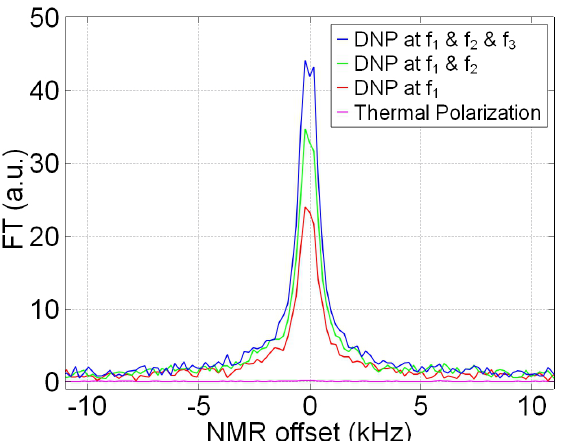
Figure 5. Comparison between thermally polarized 13 C at 6 T and hyperpolarized 13 C nuclei obtained by the optical DNP at 17.6 mT. All the measurements are performed on the same diamond at room temperature. The pink line represents FT signal obtained from thermally polarized 13 C nuclei with 400 averages. The red, green and blue lines represent the FT signals obtained with MW excitations at single ( f 1 ), double (f 1 , f 2 ) and triple (f 1 , f 2 , f 3 ) frequencies, respectively. The spectral positions of f 1 , f 2 and f 3 are indicated in Figure 2a. The 13 C polarization increases from 0.068%, through 0.094%, to 0.113%, with the number of MW